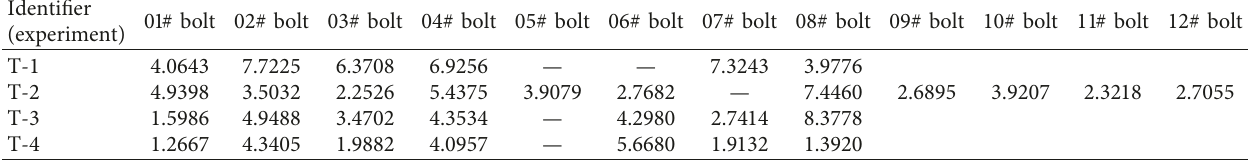
Figure 17: The response curves of the bolts force (simulation). (a) T-1, (b) T-2(1), (c) T-2(2), (d) T-3, and (e) T-4. Table 4: The pretightening forces of the bolts in the experiments